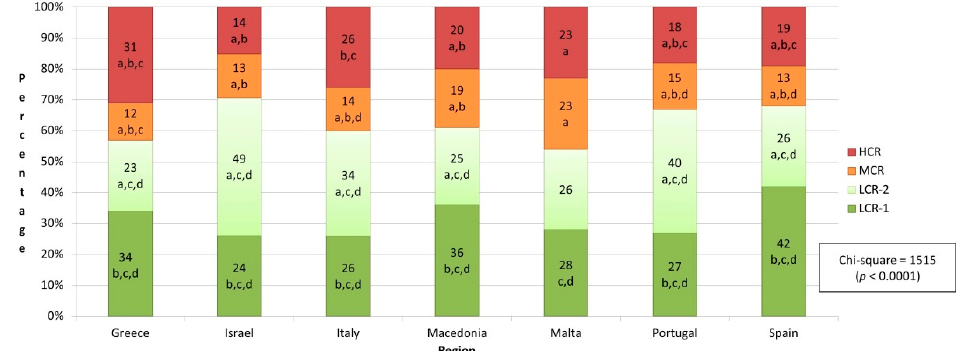
Figure 2. Clusters’ distribution based on sex. Notes: Abbreviations: HCR, high cardiovascular risk; MCR, moderate cardiovascular risk; LCR-1, low cardiovascular risk—group 1; LCR-2, low cardiovascular risk—group 2. Notes: a, statistically significantly different from first cluster ( p < 0.05; 2-tailed); b, statistically significantly different from second cluster ( p < 0.05; 2-tailed); c, statistically significantly different from third cluster ( p < 0.05; 2-tailed); d, statistically significantly different from fourth cluster ( p < 0.05; 2-tailed).